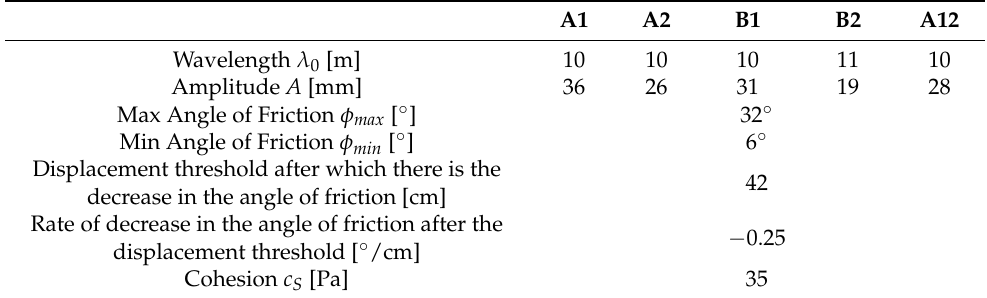
Table 2. Model parameters of the best-fitting model. The topography of the terrain values or each of the 4 glide shoes (A1, A2, B1, B2) and the virtual one (A12). The cohesion and the angle of friction, as parametrized in paragraph 5.2, are the same for each glide shoe.